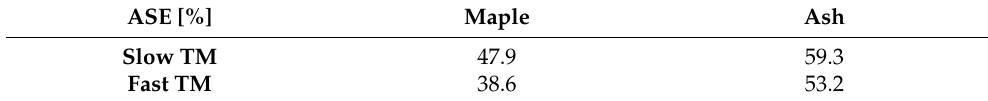
Table 4. Average anti-swelling efficiency (ASE) of thermally treated maple and ash wood. ASE [%] Maple Ash Slow TM 47.9 59.3 Fast TM 38.6 53.2